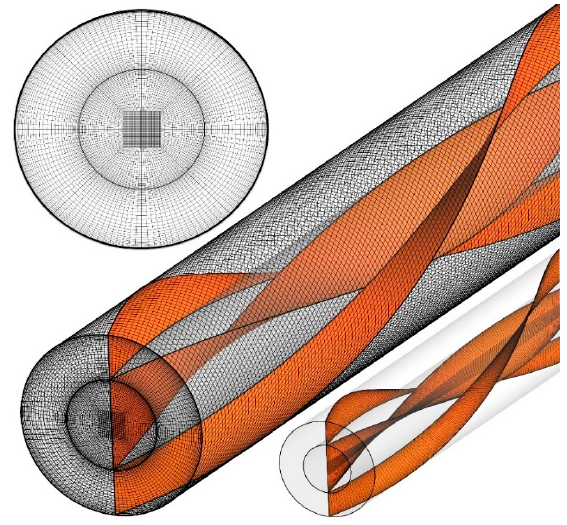
Figure 2. The meshing of the computational